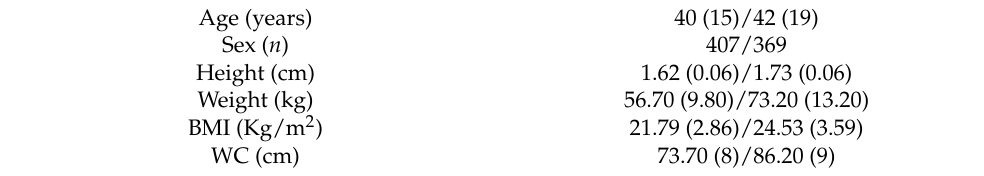
Table 1. Participants characteristics